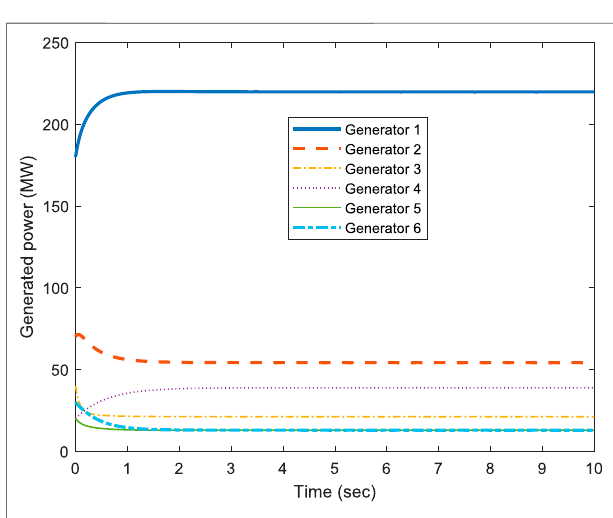
FIGURE 4 | Power generations (MW) of individual generators versus time (sec) under the conventional approach (unity weights).